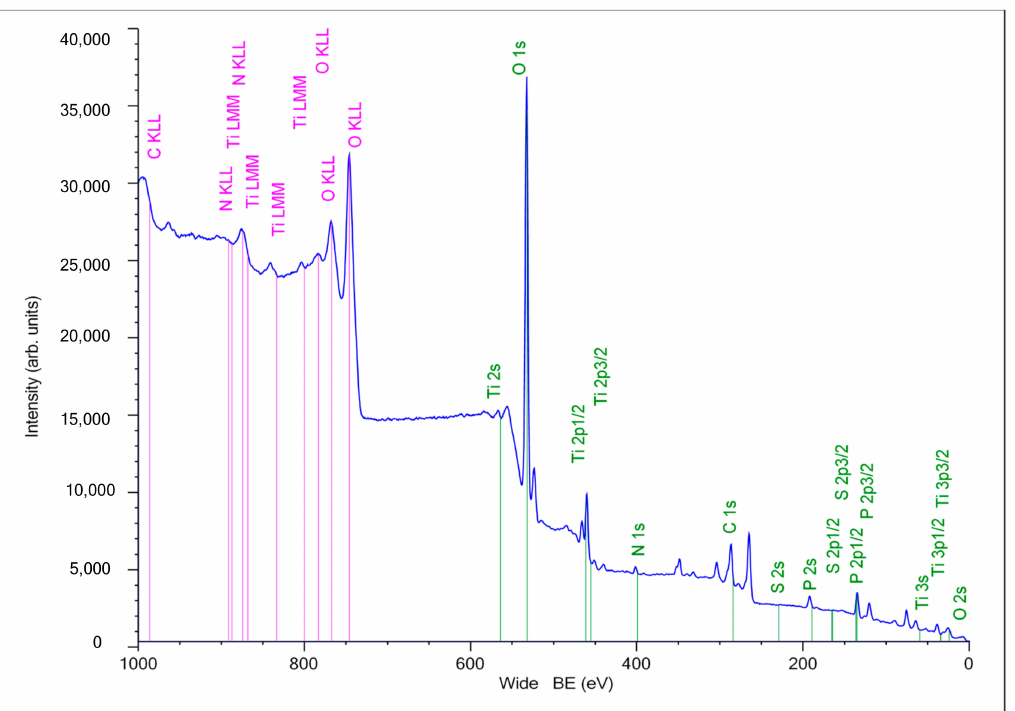
Figure 3. Survey XPS spectra of the Ti-PEO coating.